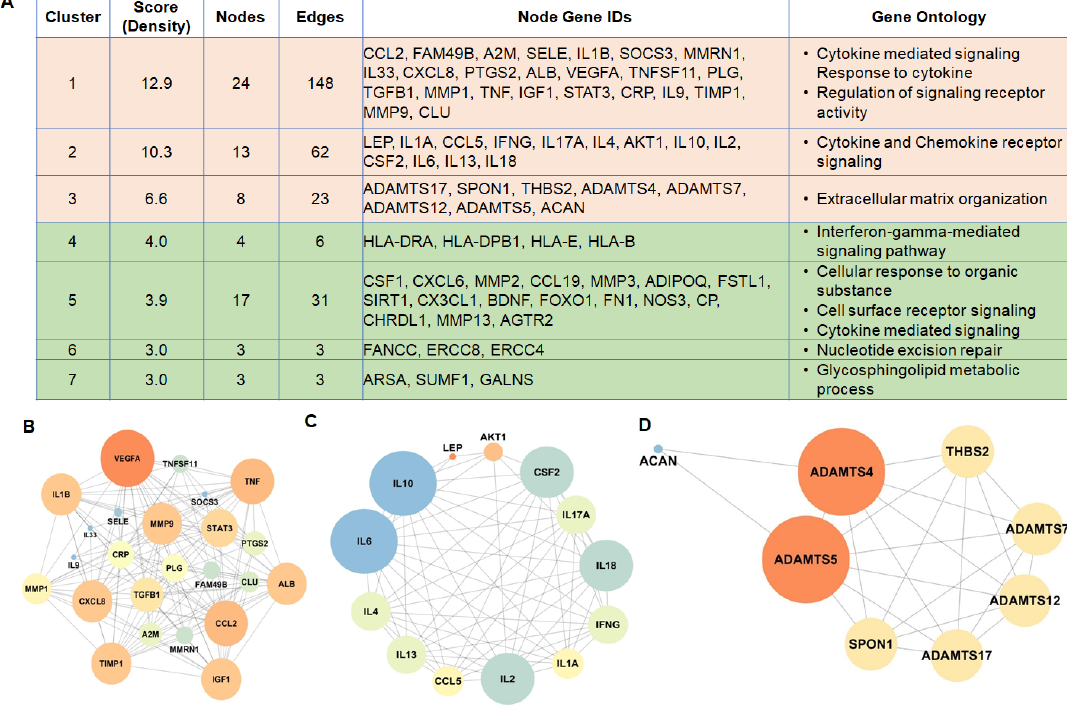
Figure 3. Cluster / module analysis in PPI network reveals the abundance of organized networks of cytokines and chemokines signaling: PPI network of IDD-related genes was constructed using the STRING database utilizing experimentally validated interactions with a combined PPI score of >